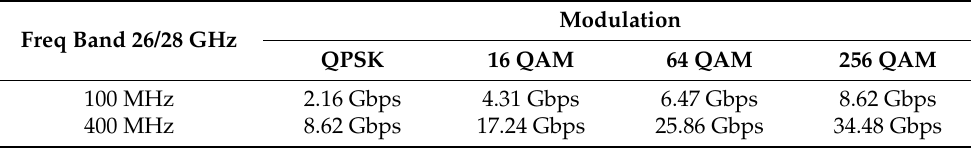
Table 1. Peak data rate vs. Modulation for 26/28